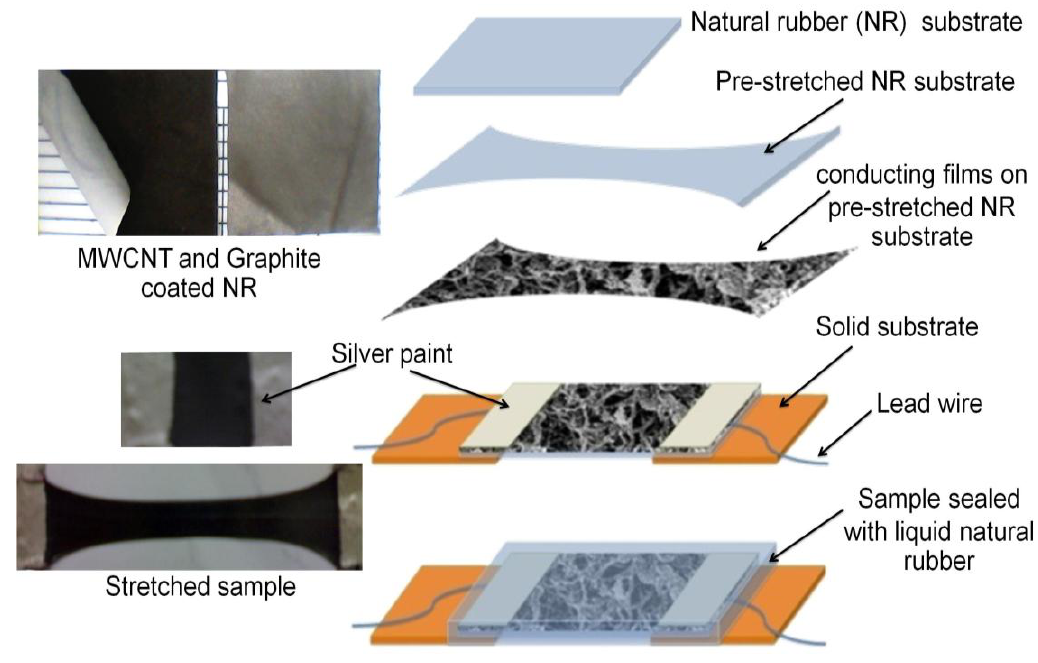
Figure 1. Schematic illustration of the steps used to prepare the test samples, which consisted of MWCNTs or graphite coated on NR.